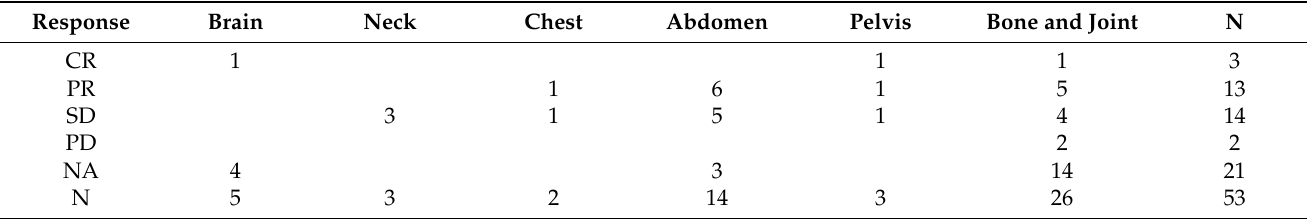
Table 4. Response of GIST at different locations to